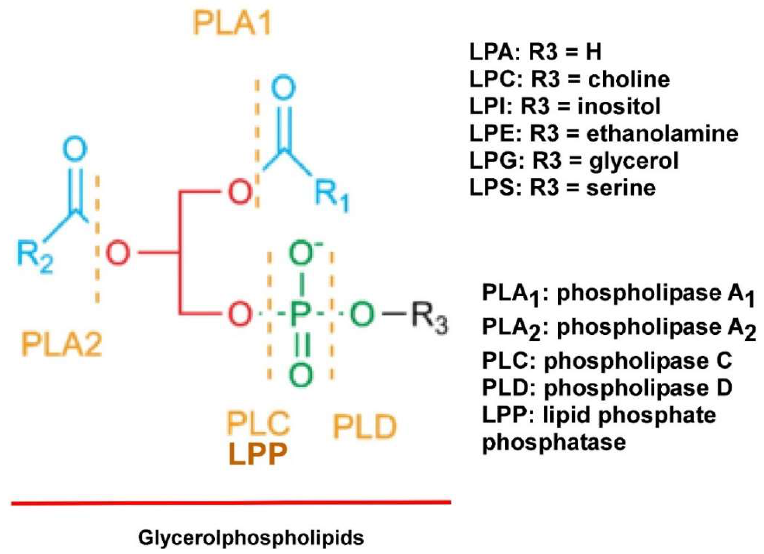
Figure 1. Structures of glycerophospholipids (PLs), lysophospholipids (LPLs only have R 1 or R 2 ) and the action sites of phospholipases. the action sites of